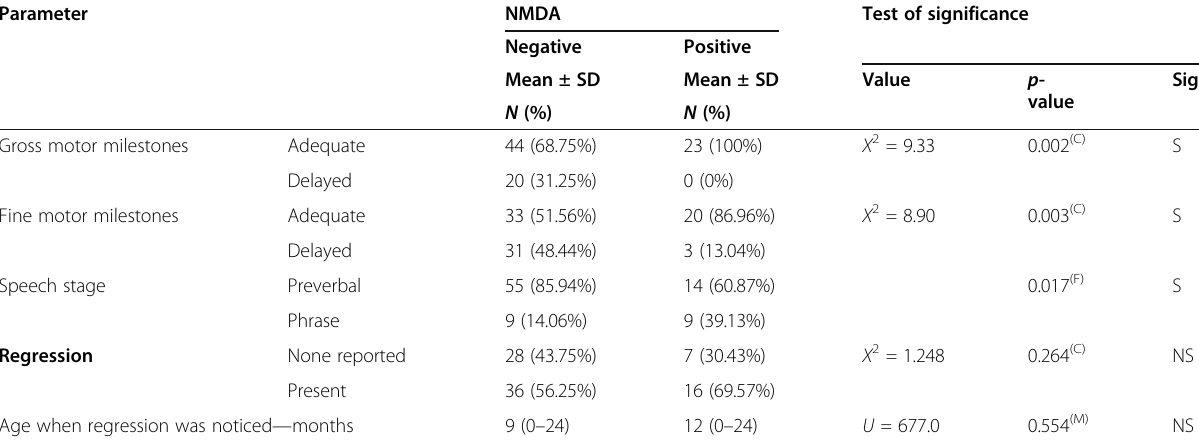
Table 2 Statistical correlation of anti-NMDAR antibody with developmental milestones in the patient group of the study